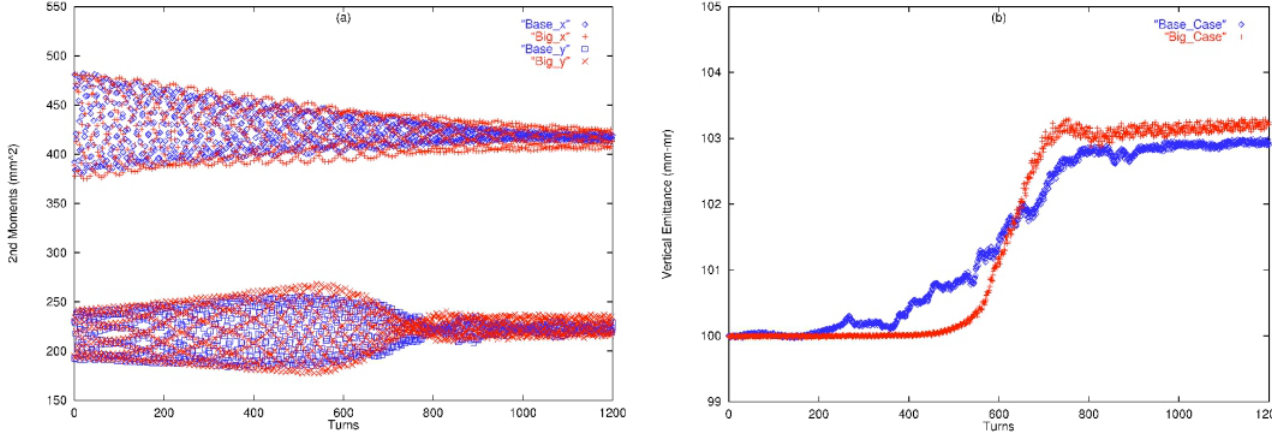
FIG. 2. (Color) (a) (cid:6)(cid:3) D x (cid:4) 2 (cid:7) and (cid:6)(cid:3) D y (cid:4) 2 (cid:7) plotted once each turn for the “base case” and the “big case”; (b) transverse rms emittances ´ y versus turn number for the base case and the big